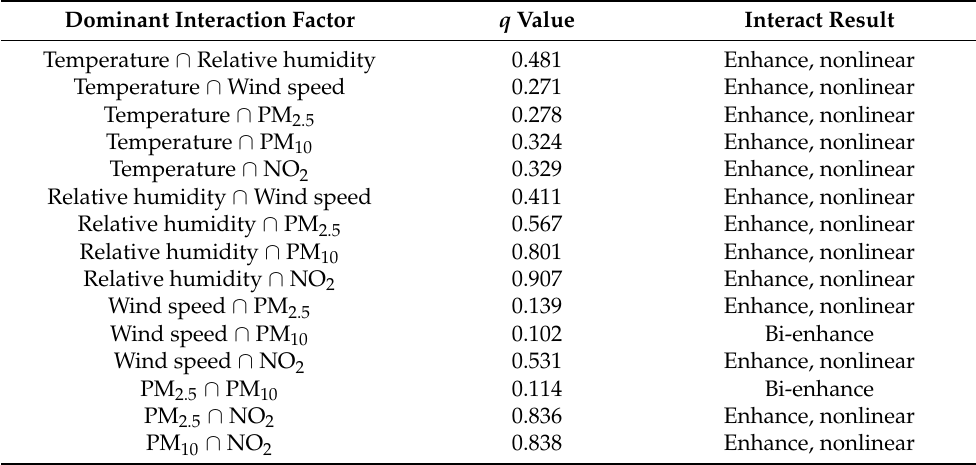
Table 4. Results of interaction detector in southern